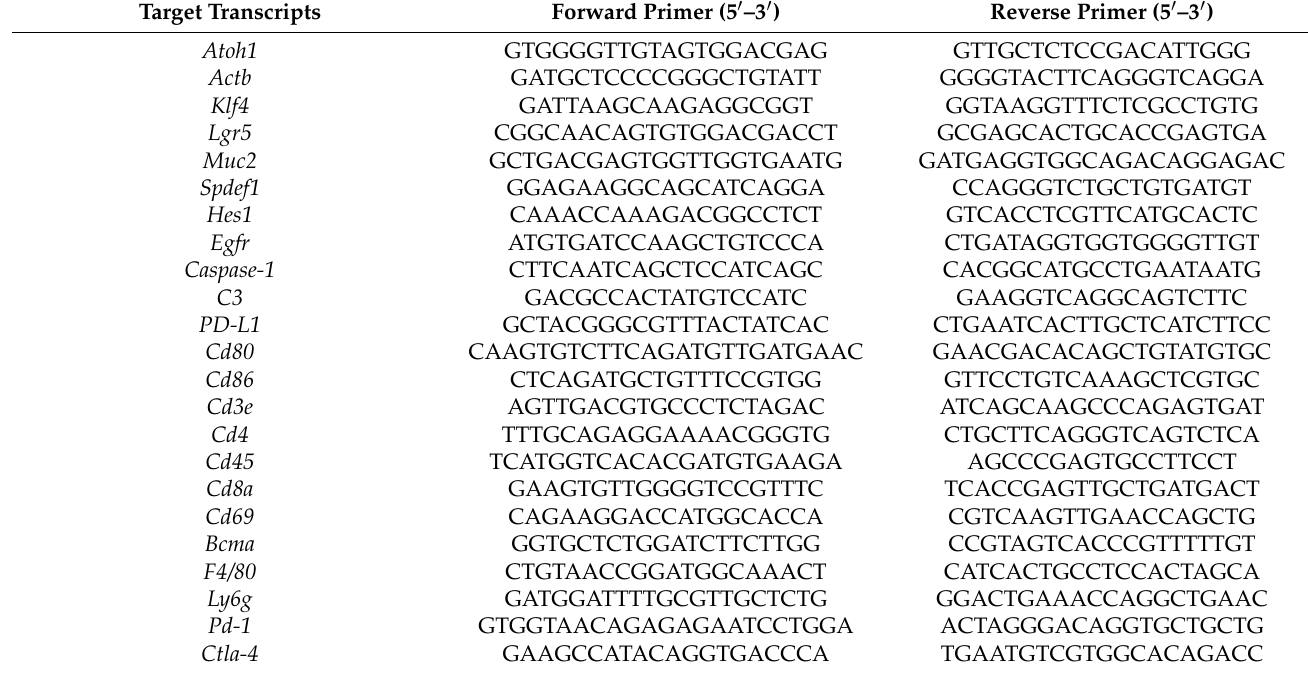
Table 2. Information on applied primer